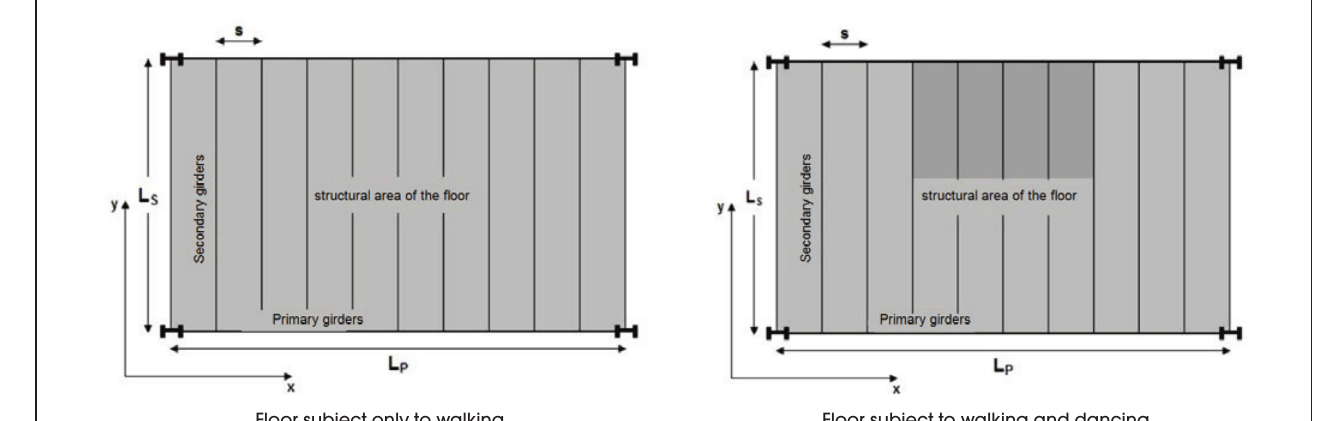
Figure 5.2 – Structural model of floors subjected to dynamic actions due to human